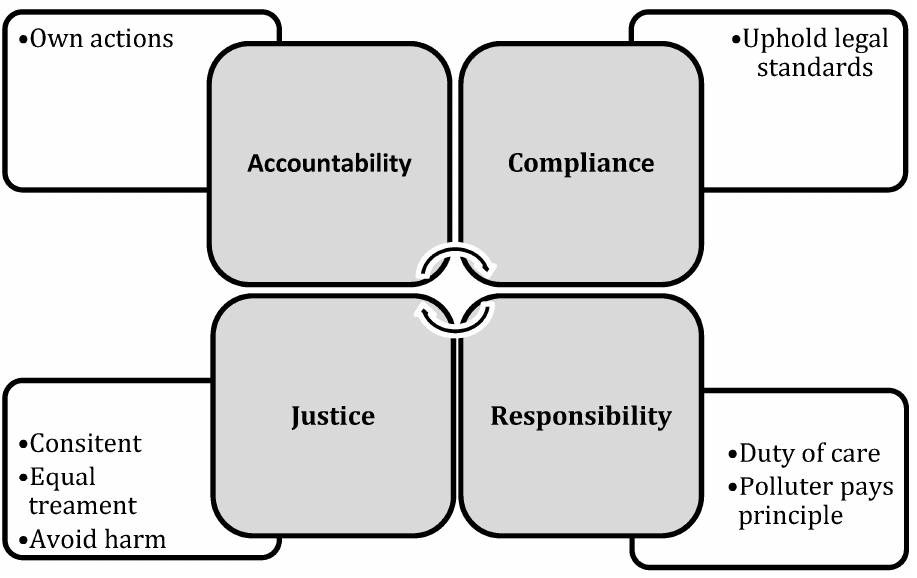
Figure 6. Suggested key elements for an ethical tailings disposal practice in South Africa.